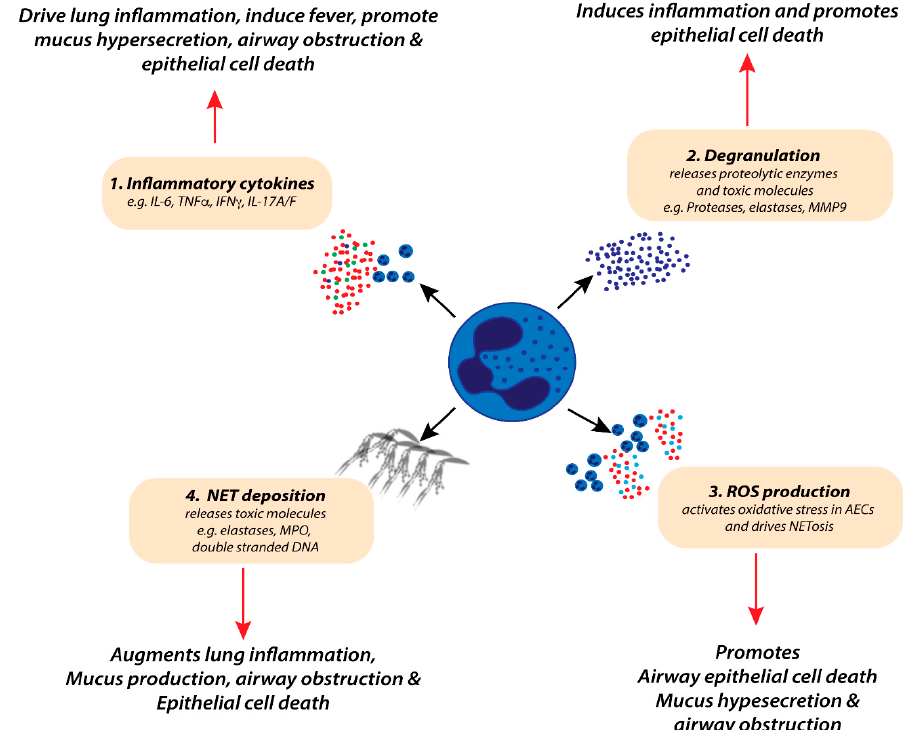
Figure 1. Potential roles of neutrophils in the pathophysiology of severe respiratory syncytial virus (RSV) bronchiolitis. Excessive neutrophil-derived inflammatory cytokine production (1), degranulation (2), respiratory oxygen species (ROS) production (3), and the release of neutrophil extracellular traps (NETosis) (4) are associated with increased lung inflammation, systemic fever, mucus hypersecretion, airway obstruction, and epithelial cell death. Together, these factors contribute to increased lung damage during severe RSV bronchiolitis.